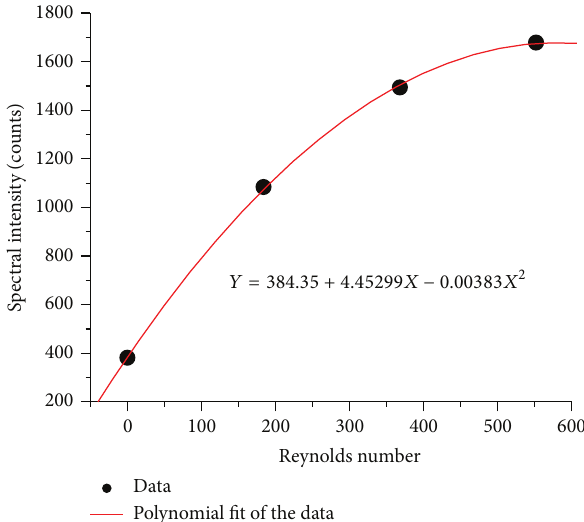
Figure 3: The spectral intensity variation of the emission data [24] with fitted polynomial at low Reynolds numbers.